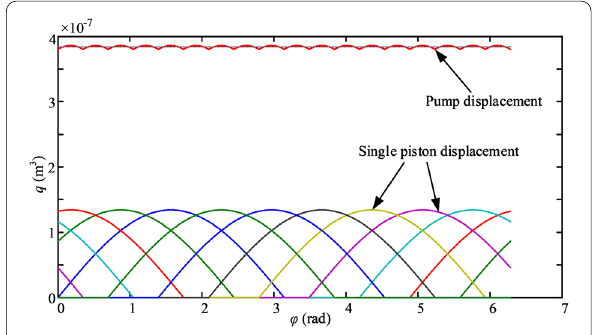
Figure 2 Flow rate characteristics of 9 pistons of the piston